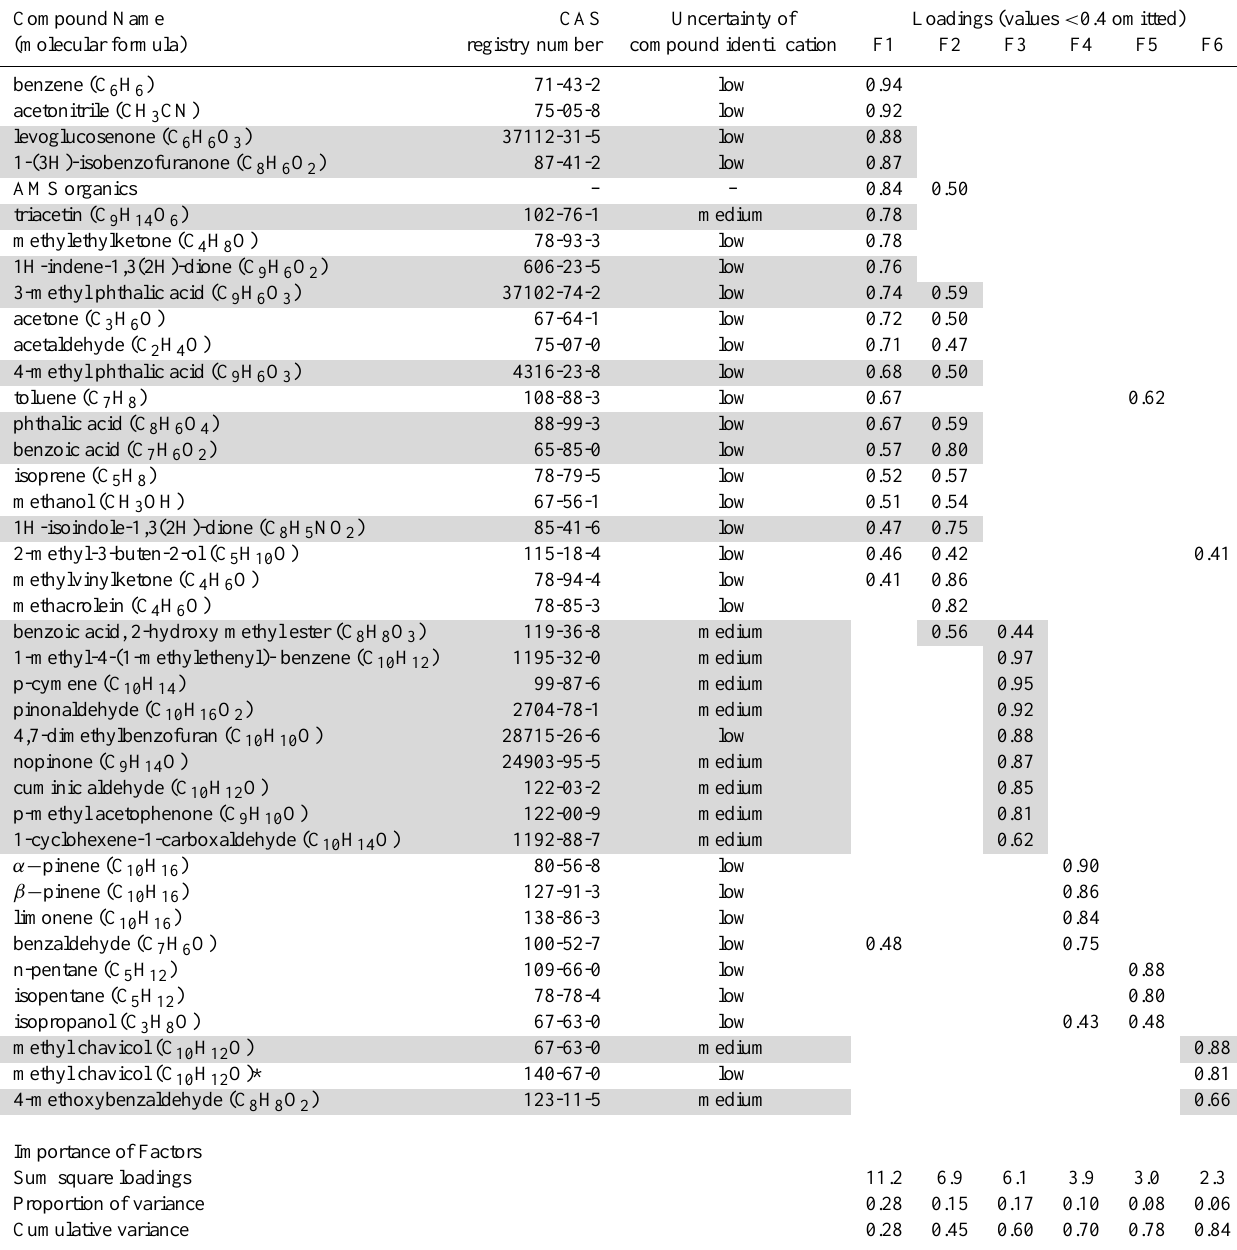
Table 2. Molecular marker compounds (particle phase compounds measured by TAG highlighted by gray shading) used in the factor analysis. Factor 1 (F1) aged biomass burning and oxidized urban emissions, Factor 2 (F2) oxidized urban emissions, Factor 3 (F3) oxidation products of temperature-driven local biogenic emission, Factor 4 (F4) monoterpene emissions, Factor 5 (F5) anthropogenic emissions and Factor 6 (F6) Local methyl chavicol emissions and oxidation. Factor analysis was performed in SPLUS 6.2 (MathSoft Inc.), using varimax rotation and principal factors extraction. The model was limited to three factors because additional factors had very low sum square loadings and did not explain any substantial portion of the variance. Proportion variance defines the fraction of the data explained by each factor. Uncertainty of compound identification is divided into three categories (i.e. low, medium and high); high uncertainty for compounds which could not be identified from mass spectral library matches or from known standards, medium uncertainty for compounds with better matches and low uncertainty for compounds with very good library matches and that could be confirmed by retention time matching to authentic